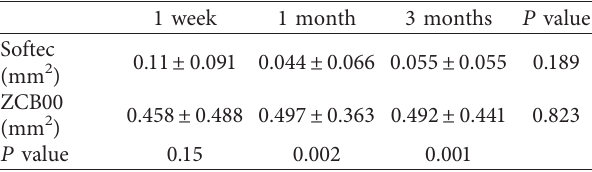
Table 3: Horizontal IOL-PC space (mm 2 ) postoperative.